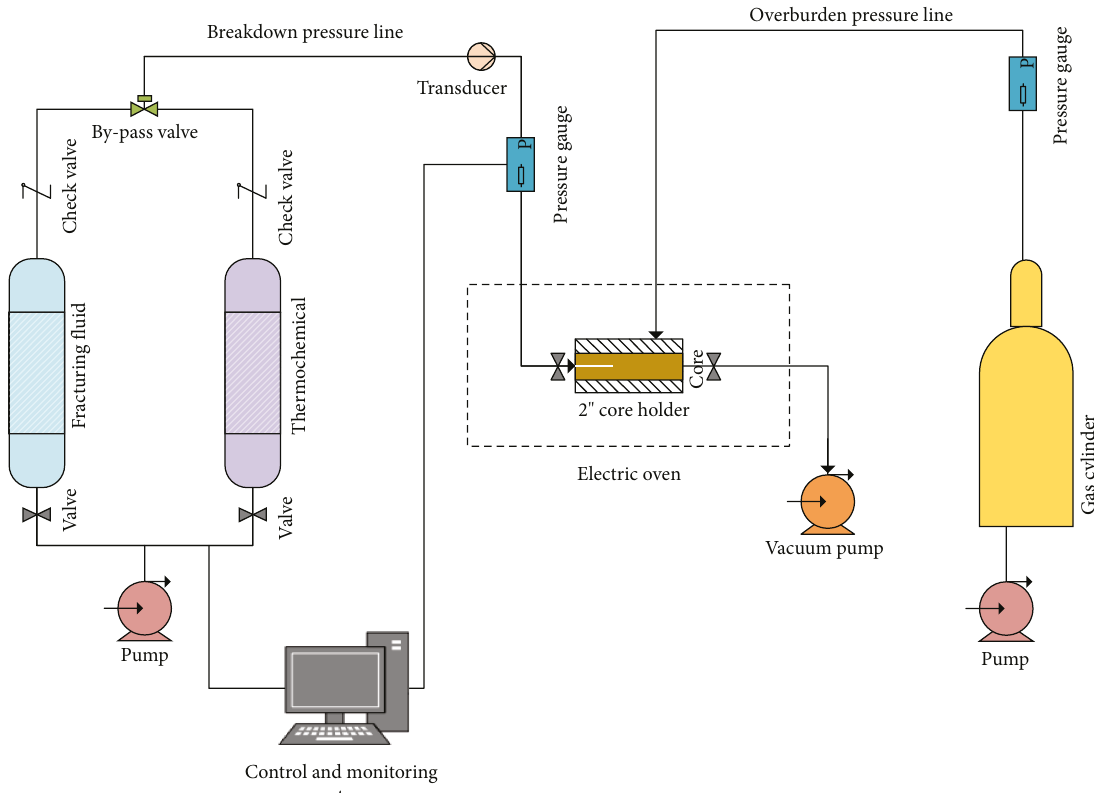
Figure 5: Schematic illustration of the apparatus used in the fracturing experiment.